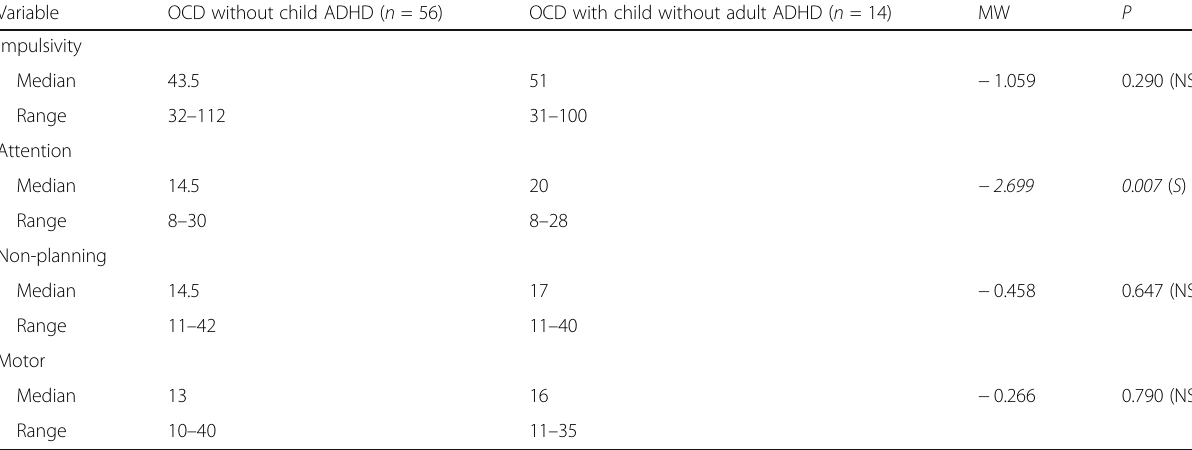
Table 3 Relationship between impulsivity in those without child ADHD and those with child and adult ADHD